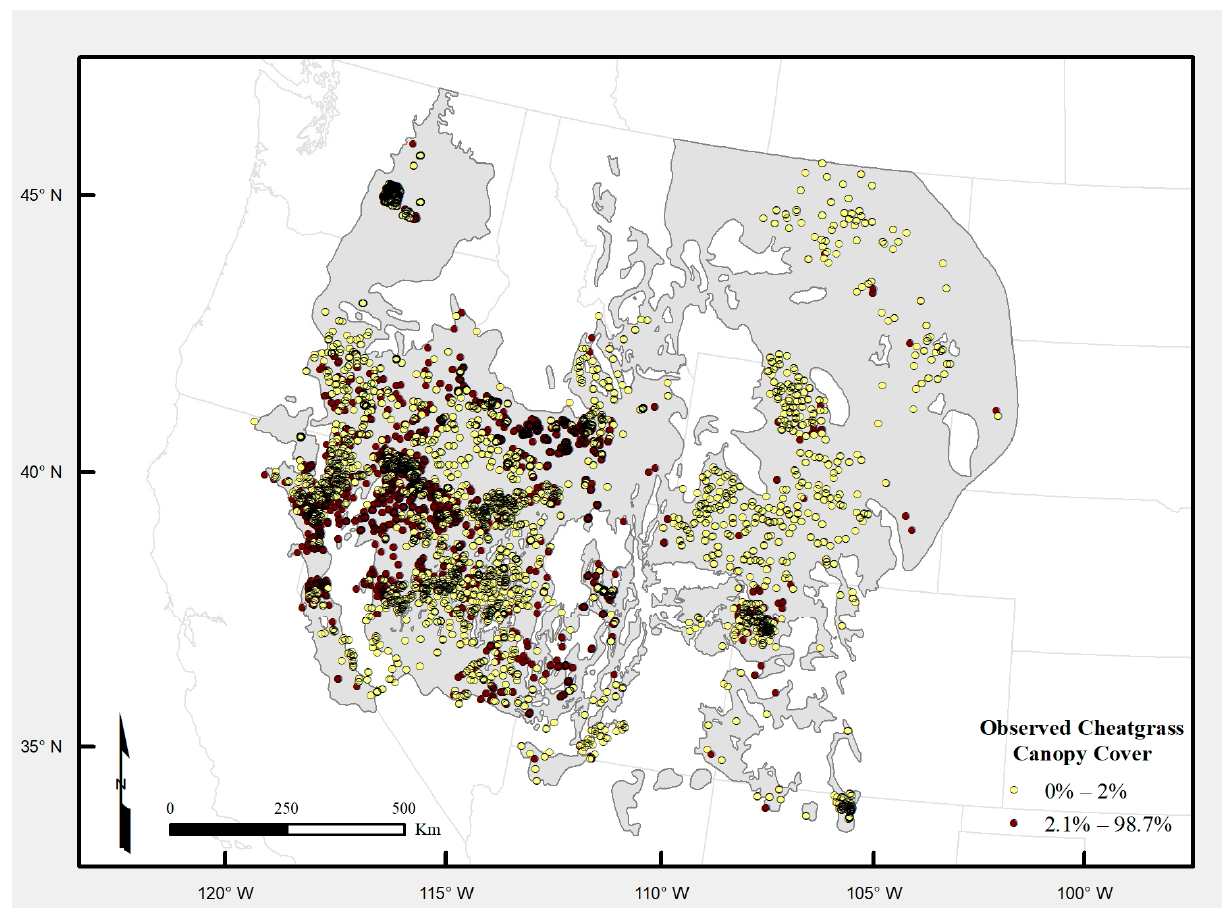
Figure 1. Distribution of field vegetation measurements (points) within the historic range of sage-grouse (gray area). For reference, field measurements are colored by their observed canopy cover values binned into the classes used in our classification.